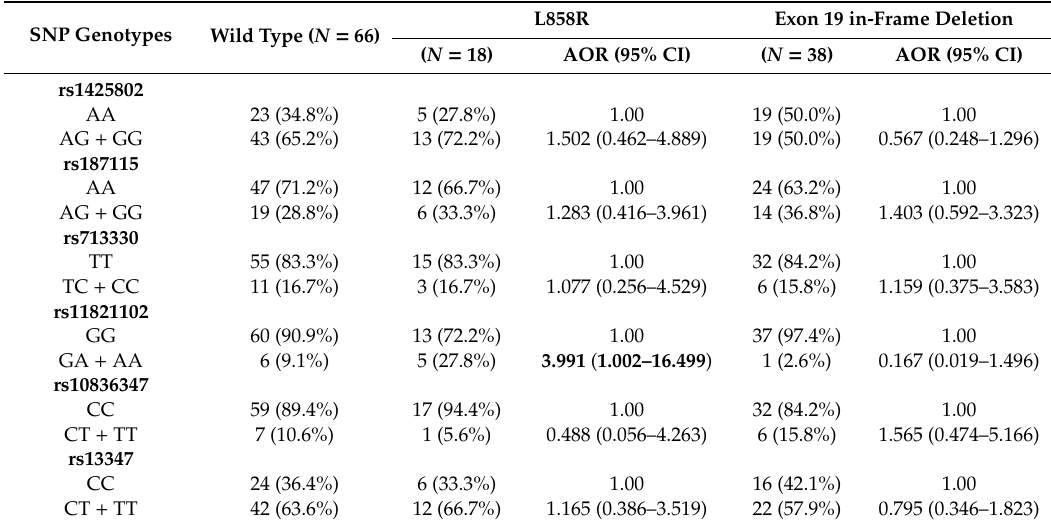
Table 3. The associations between the polymorphisms of CD44 and the EGFR hotspot mutations in male patients with lung